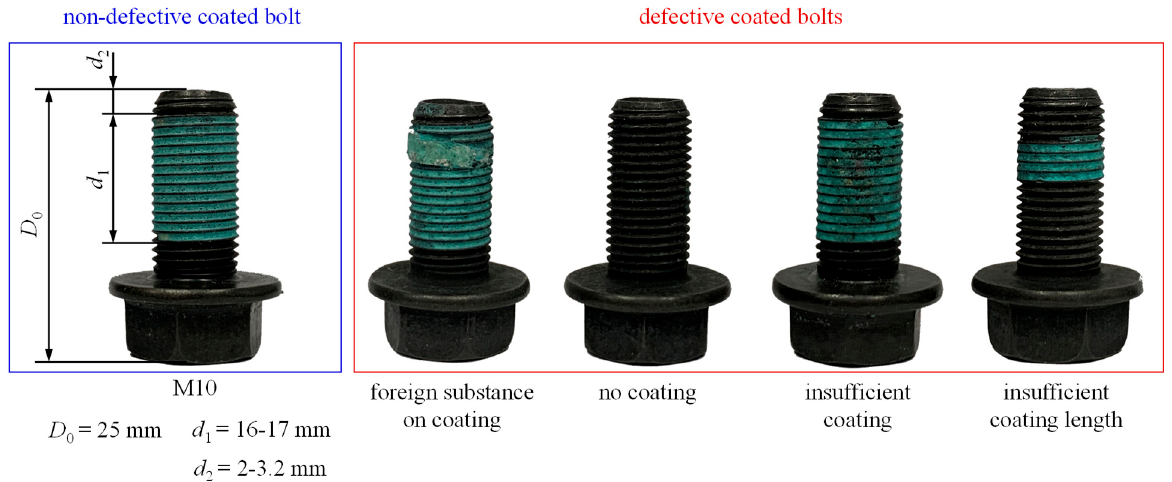
Figure 2. Defect classification criteria of coated bolts.